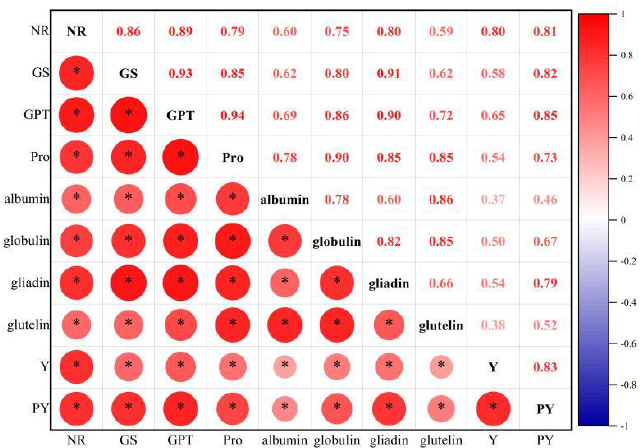
Figure 6. Correlation between the activities of key enzymes in nitrogen metabolism and protein content in grain under different nitrogen supply levels. “*” indicate significant difference at 0.05 levels. NR: Nitrate reductase; GS: Glutamine synthetase; GPT: Glutamic pyruvic transaminase; Pro: Protein; Y: Yield; PY: Protein